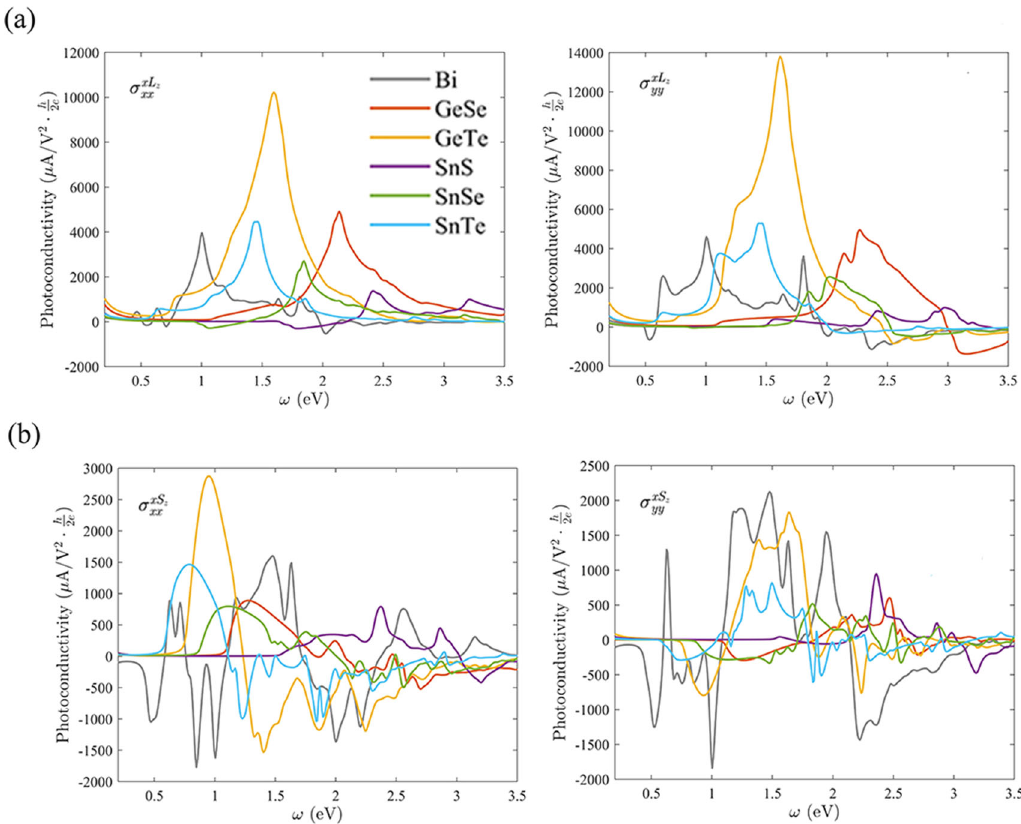
Fig. 6 Photoconductivities of other systems. a BOPV and b BSPV conductivity coef fi cients of other similar 2D ferroelectric